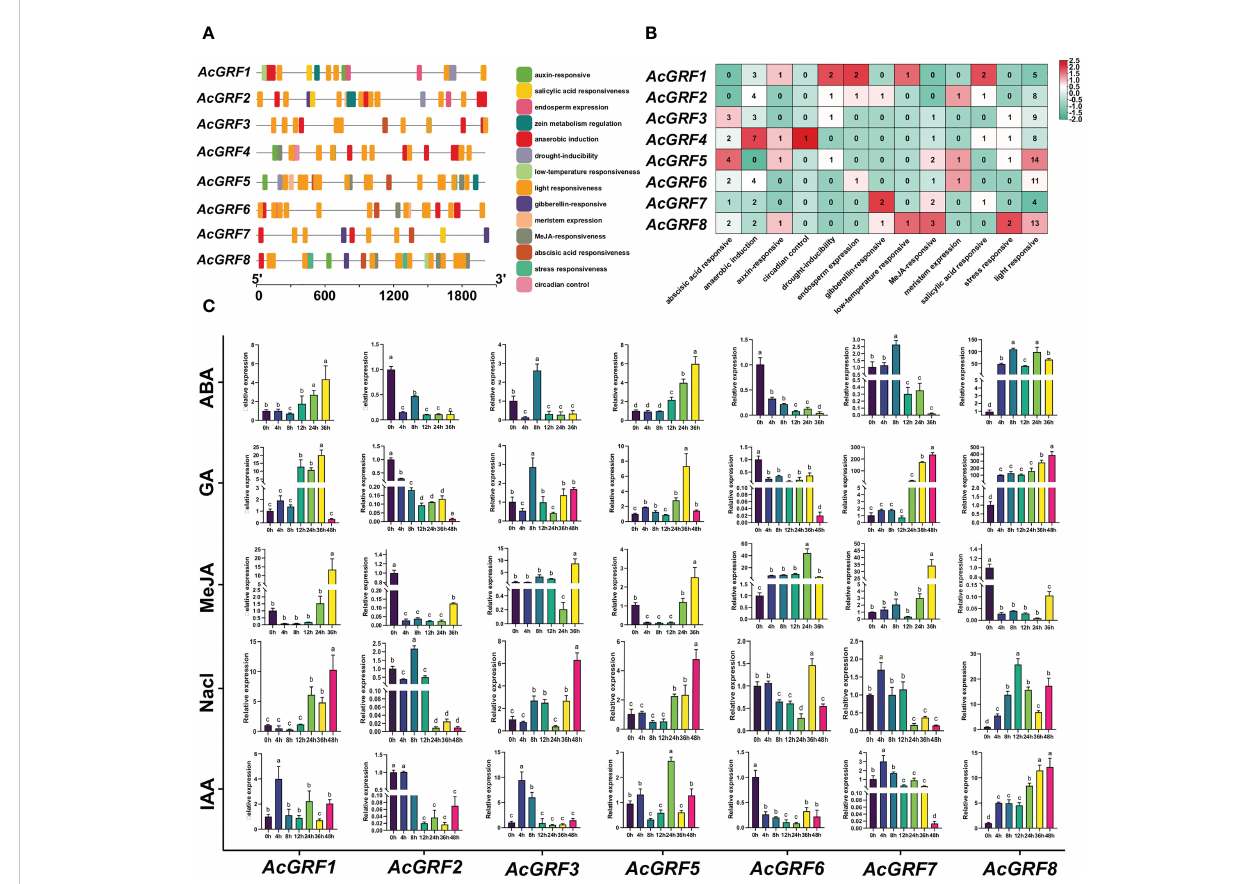
FIGURE 4 cis -Elements in AcGRF gene promoters and AcGRF expression pro fi les under hormone and salt stress treatments. (A) cis -Acting elements in the 2,000-bp region upstream of the AcGRF genes. (B) Distribution of cis-Acting elements of the AcGRF genes. (C) AcGRF gene expression pro fi les under different hormone and salt stress treatments. Data were normalized to the expression of b -actin and expressed as mean ± standard deviation. Different lowercase letters indicate signi fi cant differences between treatment times ( P < 0.01, F